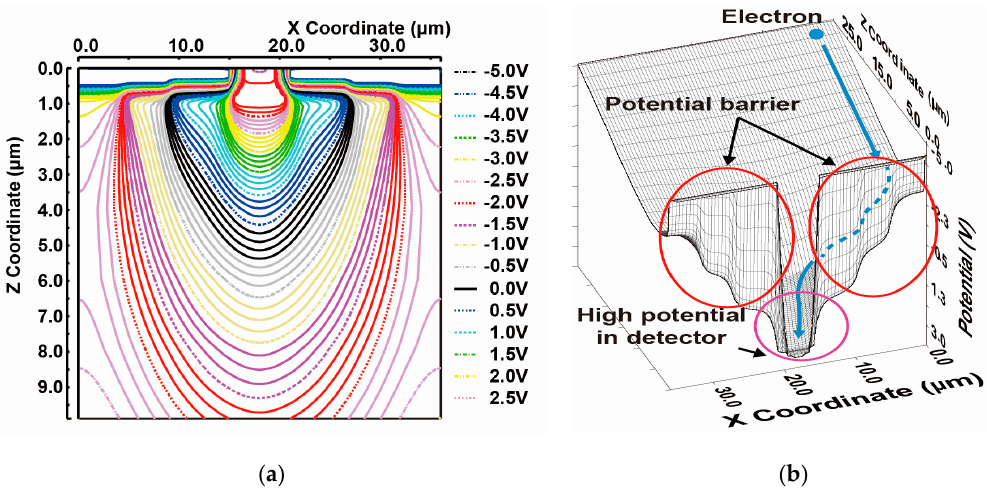
Figure 7. 2-D (X-Z) Equipotential plot ( a ) and Bird’s Eye View of the 2-D (X-Z) Potential ( b ).